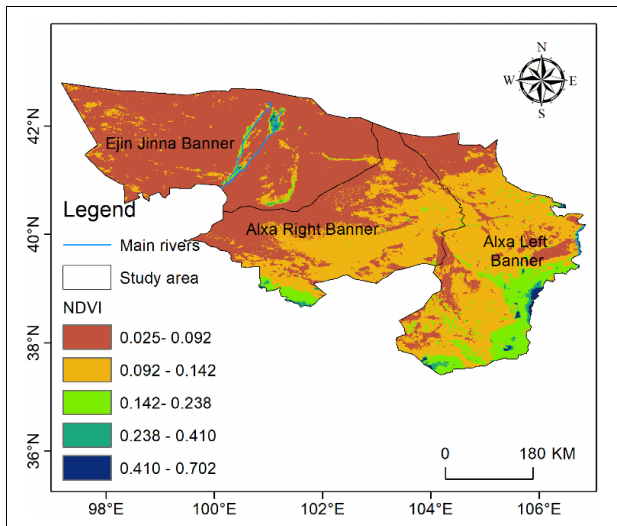
FIGURE 2 | Spatial distribution of 20-year overall NDVI mean values.